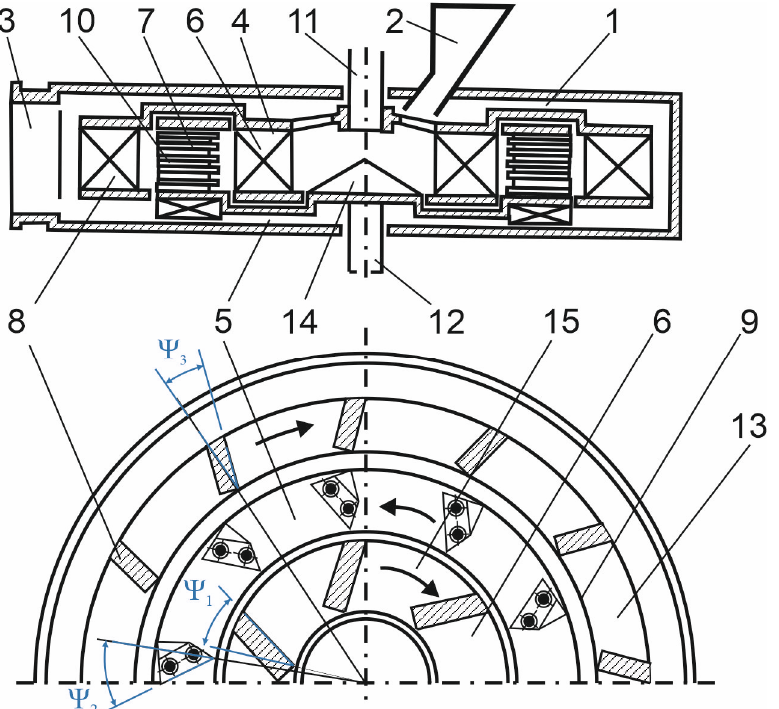
Figure 3. Disintegrator (shock-centrifugal shredder) with intermediate separation in a centrifugal field (own study based on [7]): 1—housing; 2—loading funnel; 3—exit hole; 4—the upper disc; 5—counter rotating disk; 6—flat element of the I-th row; 7—percussive elements of the intermediate row; 8—flat shock elements of the last row; 9—ring; 10—set of knives of the i-th row; 11—upper shaft; 12—lower shaft; 13—casing; 14—cone; 15—ower disk.